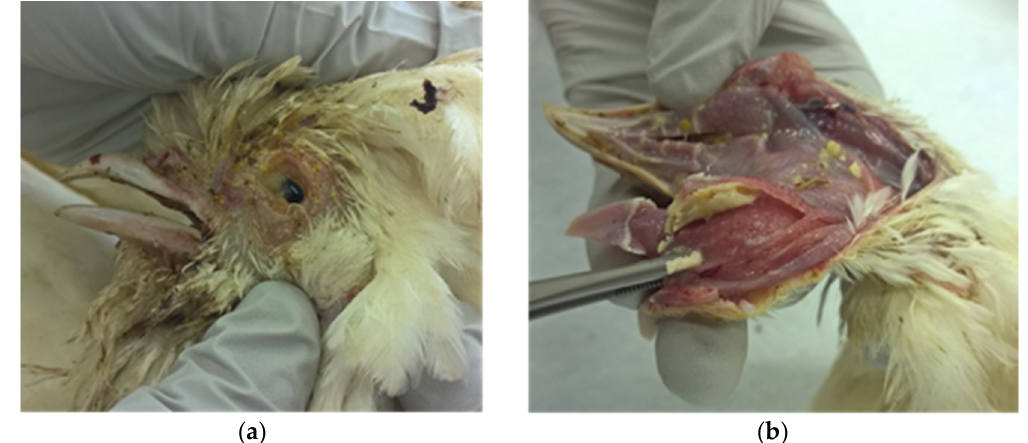
Figure 1. Gross pathological findings in submitted hens: ( a ) Fibrinous oculonasal discharges; ( b ) Severe fibrinous to caseous tracheitis.